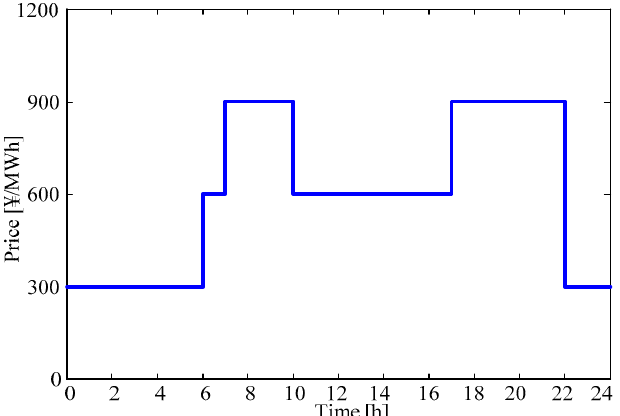
Figure 4. Price of electricity purchased by the distribution company.